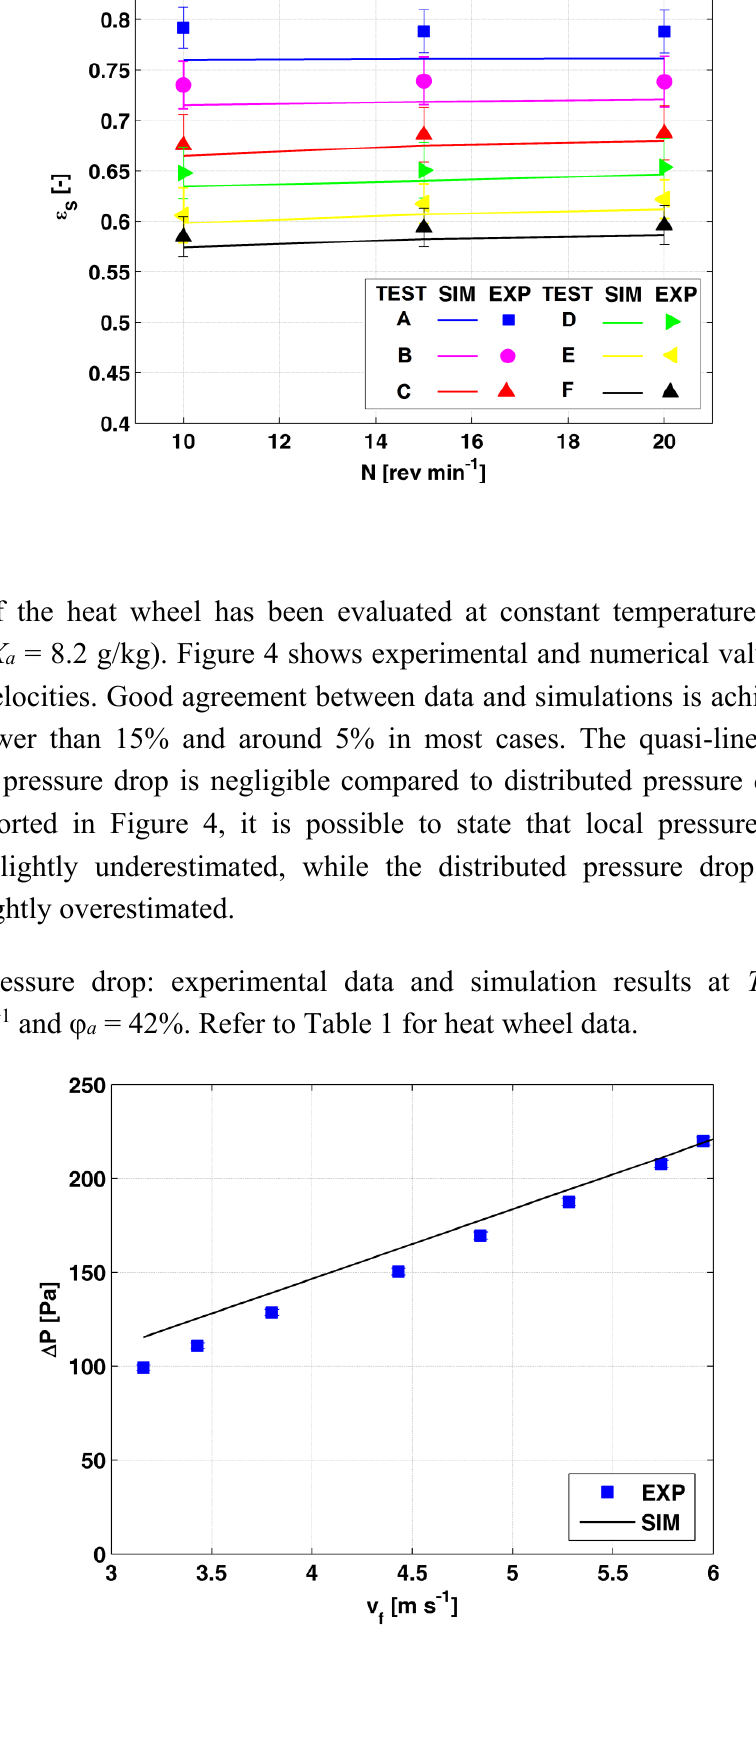
Figure 3. Sensible effectiveness: Experimental data and simulation results. Refer to Tables 1 and 2 for heat wheel data and test conditions.